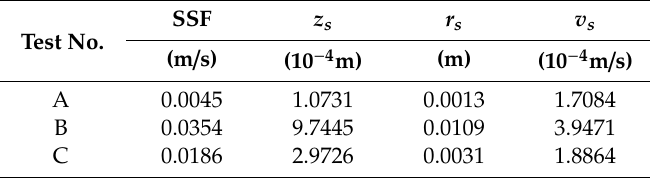
Table 4. Time-average RMSE of EnKF for di ff erent test in Table 3. Test